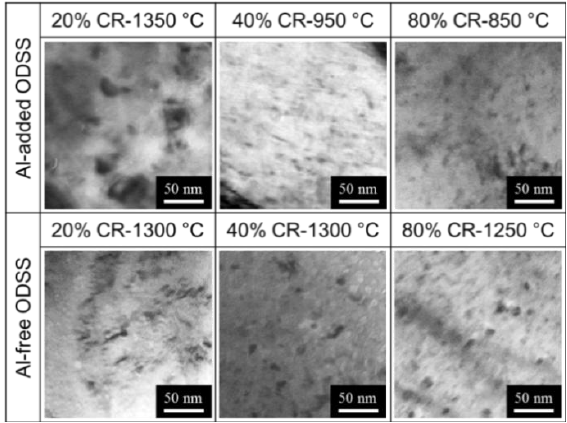
Figure 8. Dispersion morphology of oxide particles at each isothermal annealing condition for 15Cr-ODS ferritic steels with and without Al addition.